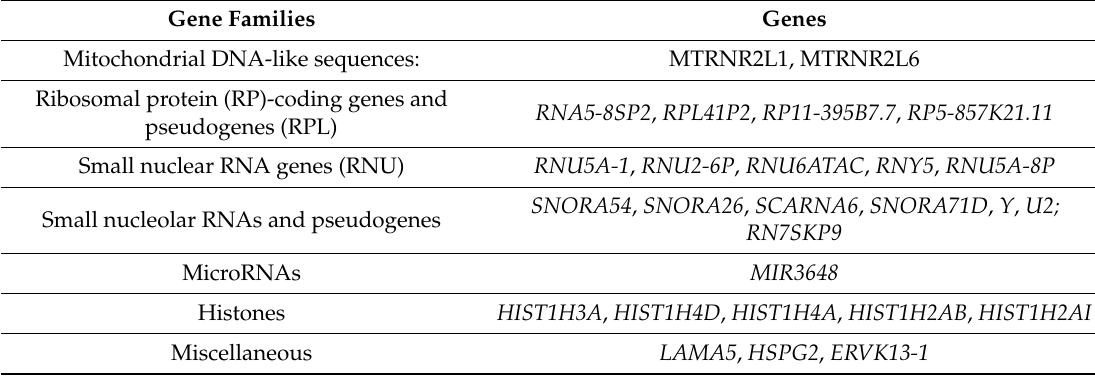
Table 4. Overlapping genes deregulated in SNU475 + daclatasvir, SNU449 + sofosbuvir and Huh7 + sofosbuvir (all with increased